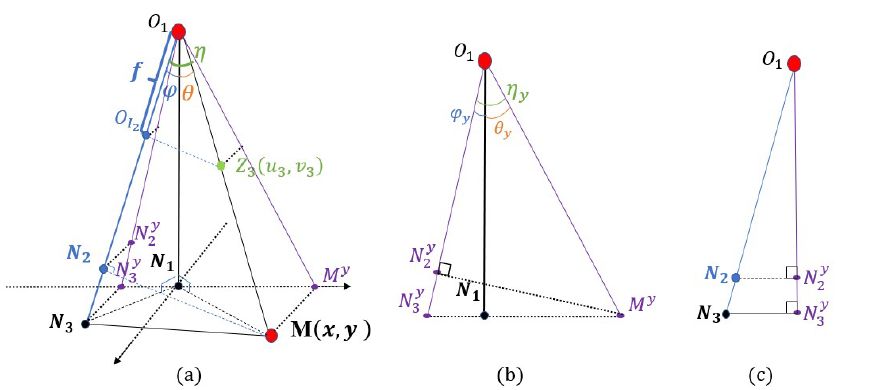
Figure 8. Some details of Figure 7: ( a ) the object plane P 1 contains points, M , N 1 , and N 3 ; ( b ) the plane contains points O 1 , N 1 , M y , N y